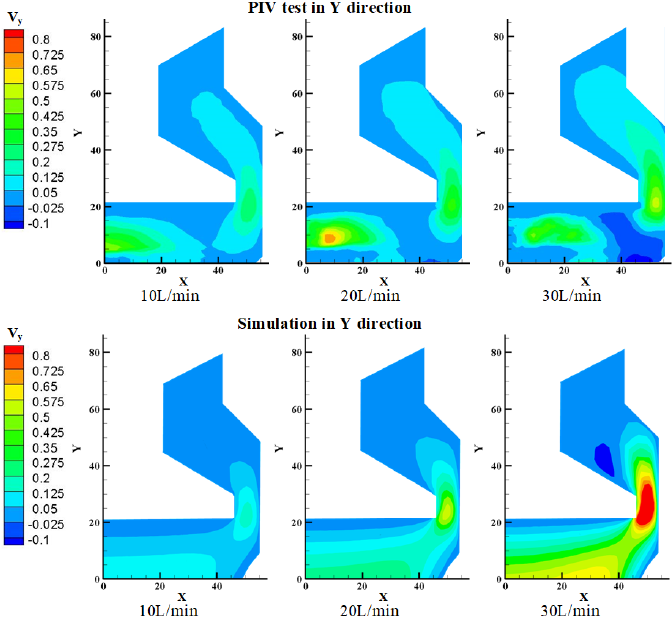
Figure 5. Comparison of PIV test results with simulation results in Y